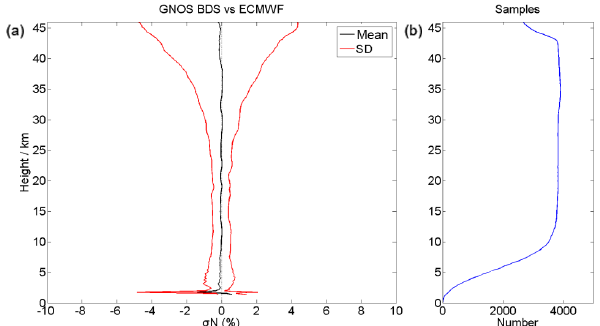
Figure 7. Refractivity deviation from the ECMWF analysis for FY- 3C GNOS BDS. The description is the same as for Fig. 6 (source: Liao et al.,